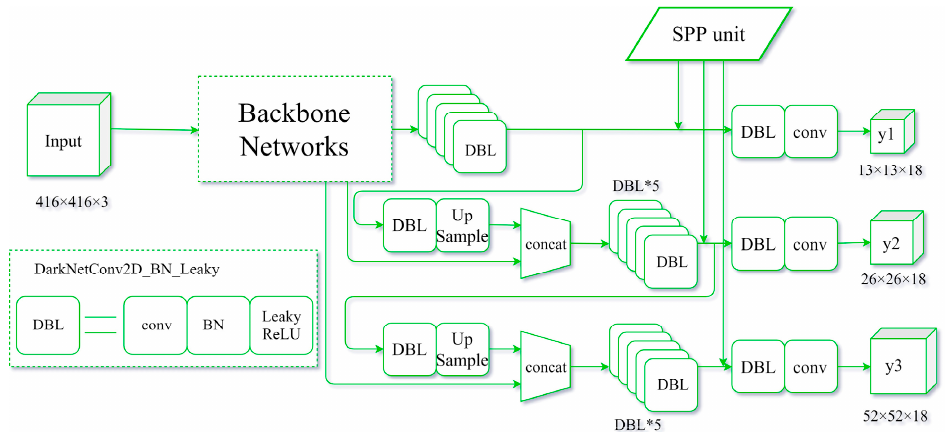
Figure 16. Structure of SPP3-YOLOv3-MN model.